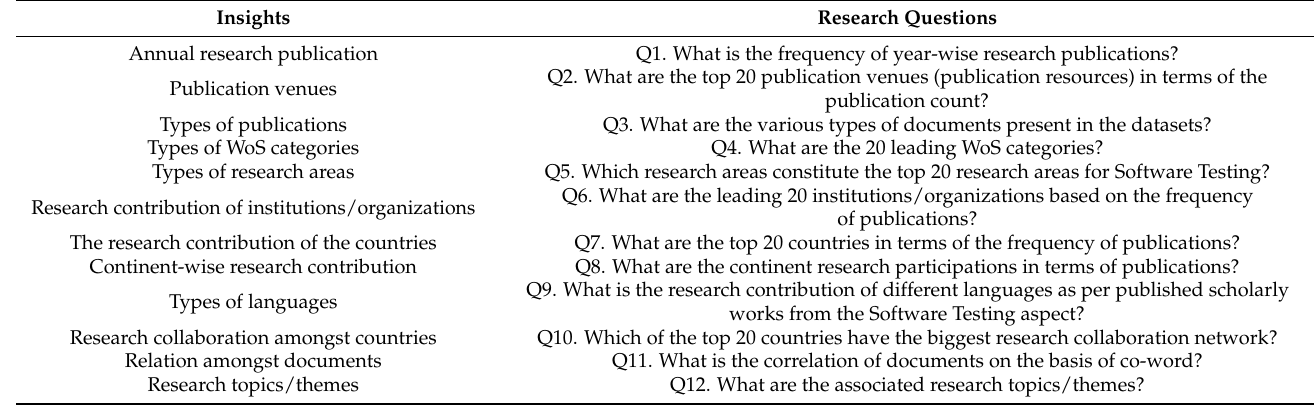
Table 4. Research questions to analyze datasets for 2016–2018 and 2019–2021.